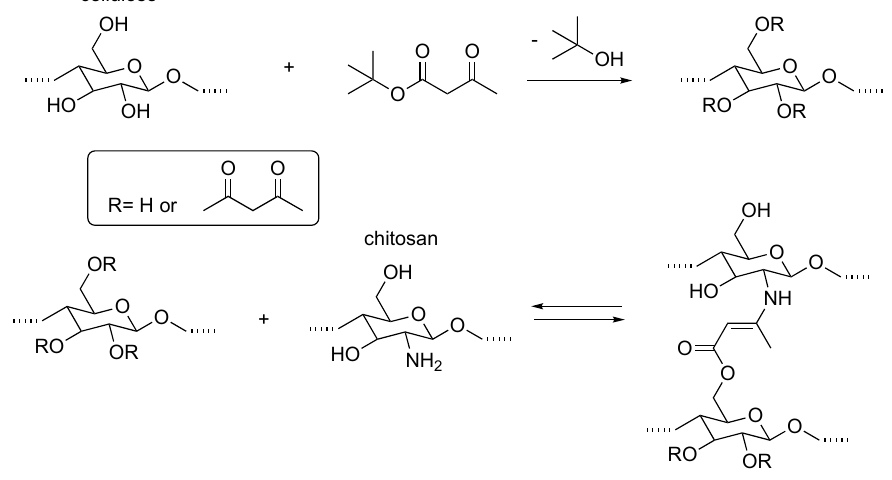
Figure 10. Polysaccharide hydrogels based on covalent enamine bond. Adapted and re-drawn from [29].